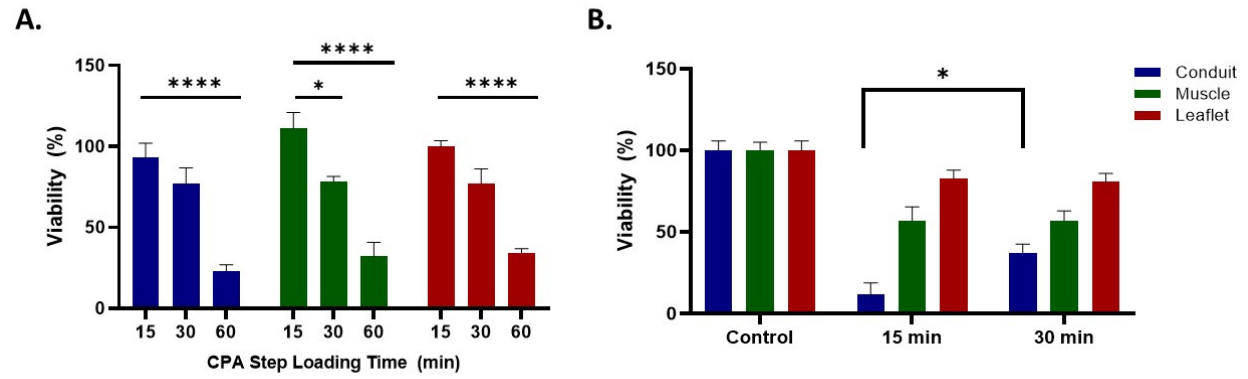
Figure 5. Aortic valve viability after loading, CPA exposure, and rewarming. ( A ) CPA exposure toxicity on heart valve tissues. Heart valve was exposed to CPA in stepwise manner for various time intervals. Longer exposure reduced the viability of the samples due to CPA toxicity. N = 5–11 ( B ) Heart valve nanowarming recovery viability using different CPA loading durations. N = 6–15. Viability was assessed using alamarBlue. Statistical significance is indicated with asterisks: * p < 0.05; p < 0.001; **** p < 0.0001. The one-way and two-way analysis of variance (ANOVA) with Tukey’s multiple comparison tests (GraphPad Prism, GraphPad ® Software, Inc., San Diego, CA, USA) were performed on data presented as the mean ± 1 standard error.